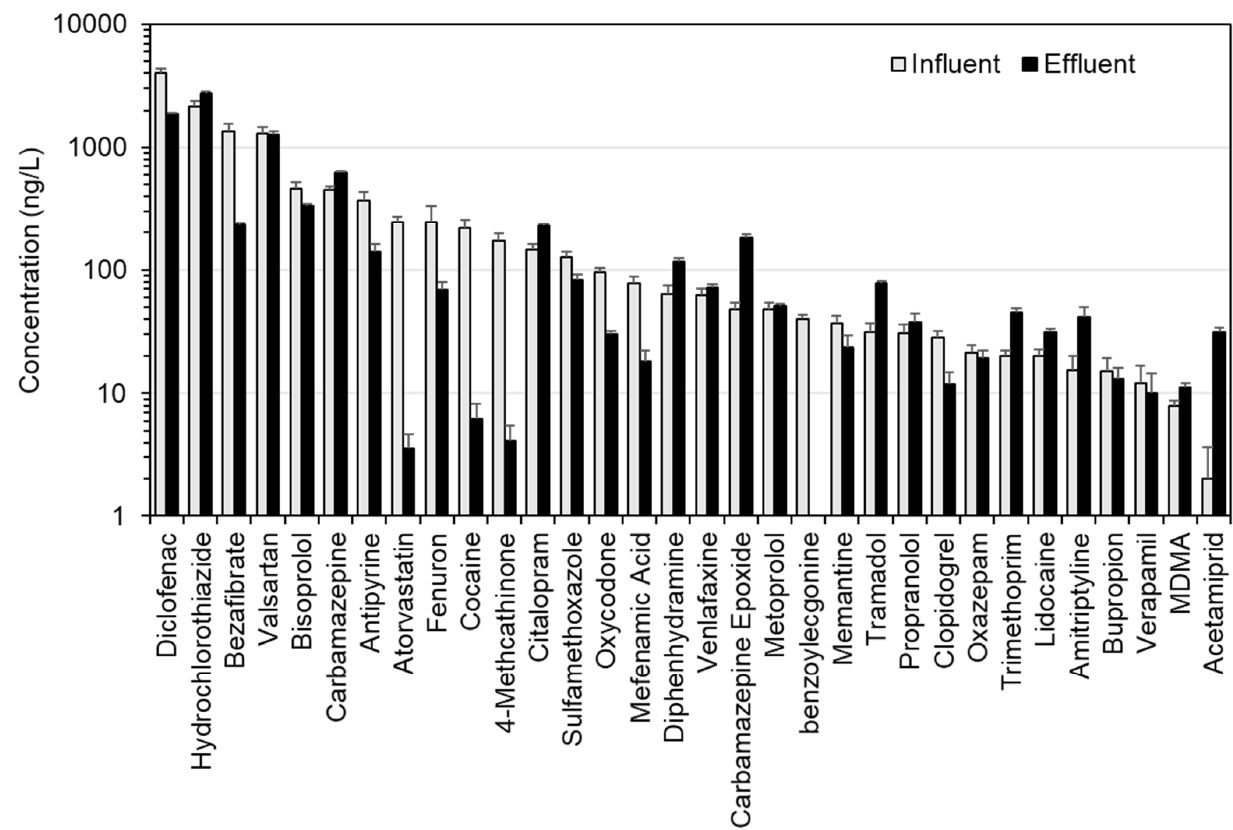
Figure 4. CEC concentrations in untreated and treated wastewater grab samples collected during Campaign 2 in the Selters district, Germany. Error bars represent the standard deviation of triplicate measurements.